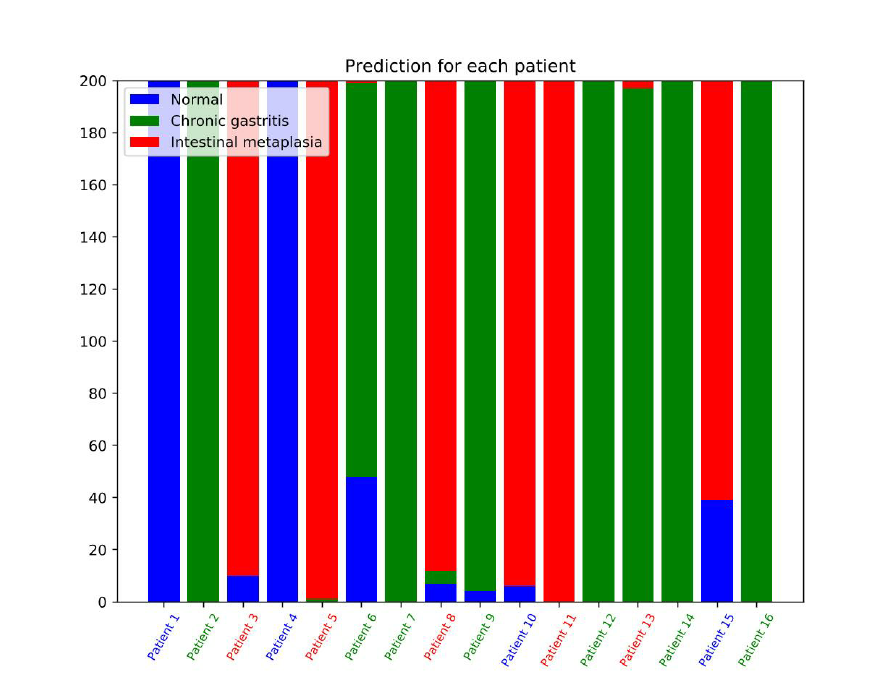
Figure 6. Results by